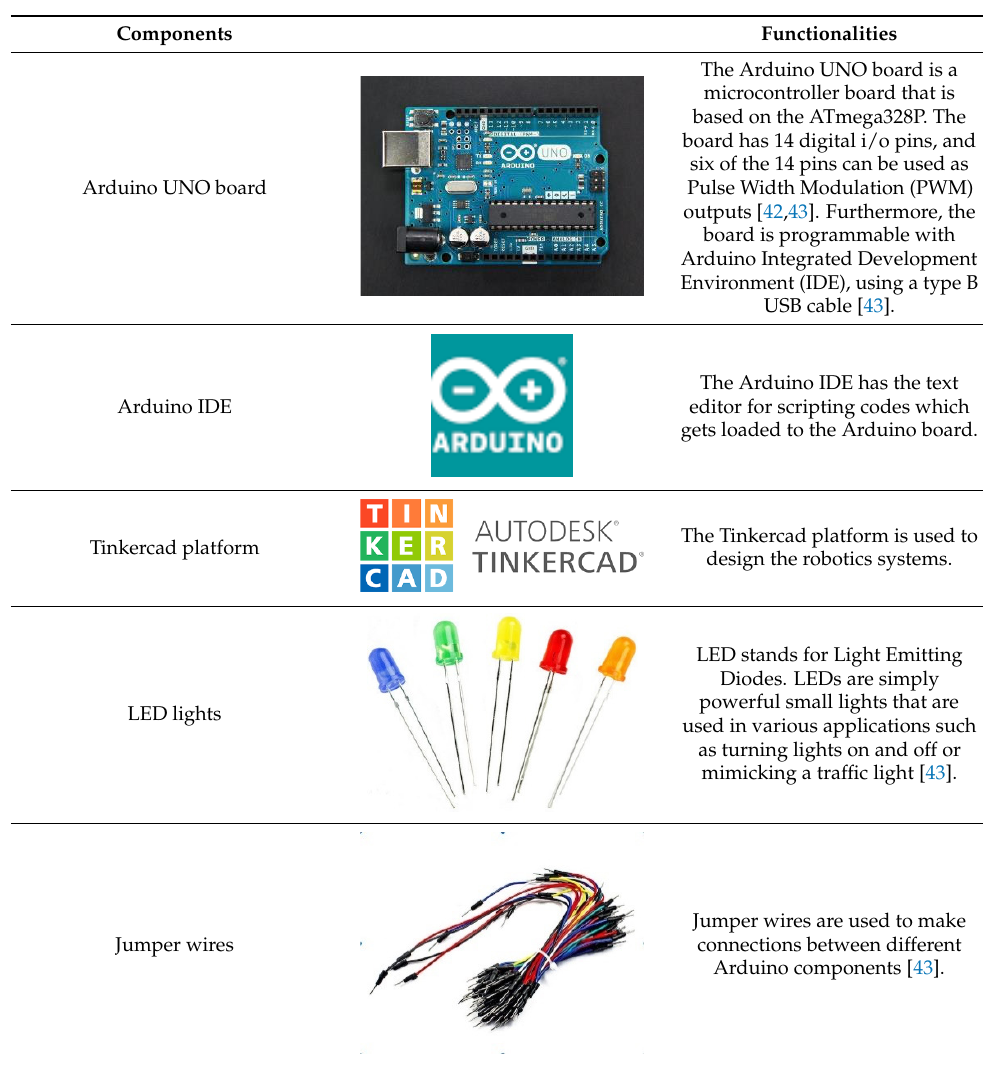
Table 3. Technologies